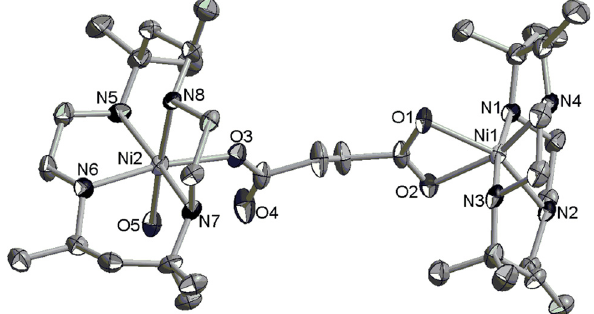
Table  : Data collection and